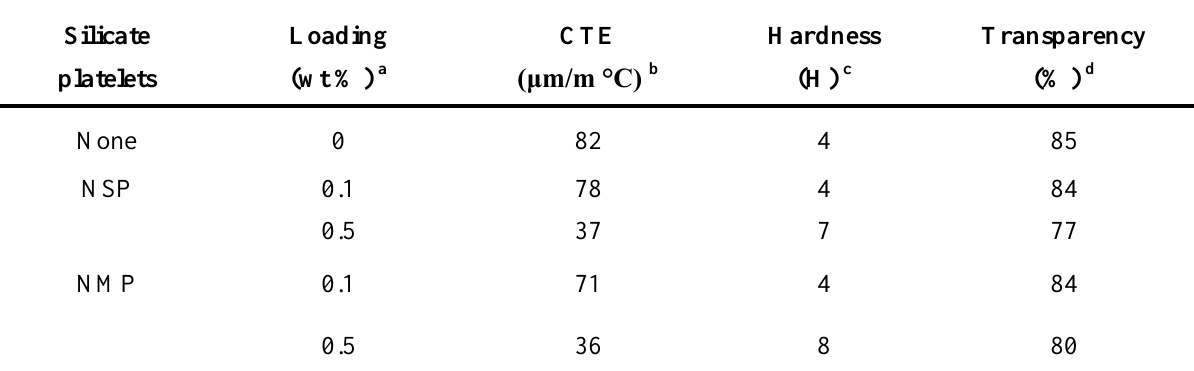
Table 2. Properties of anhydride-cured aliphatic epoxy nanocomposites with silicate platelets (reprinted with permission from reference